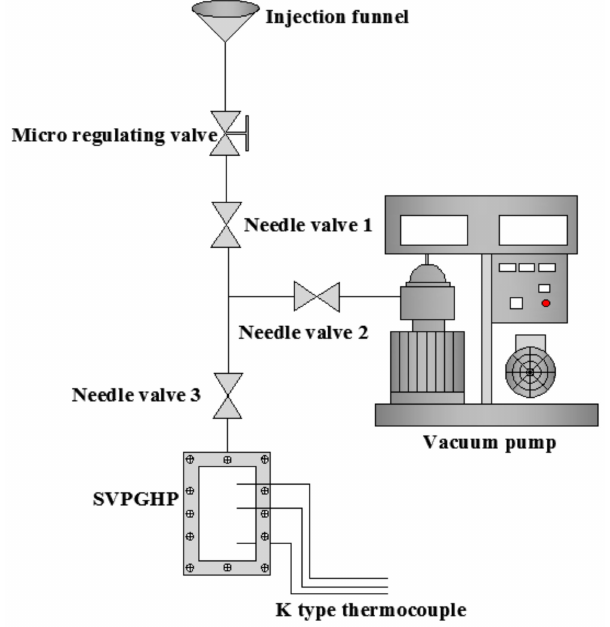
Figure 3. A schematic diagram of vacuum injection for the